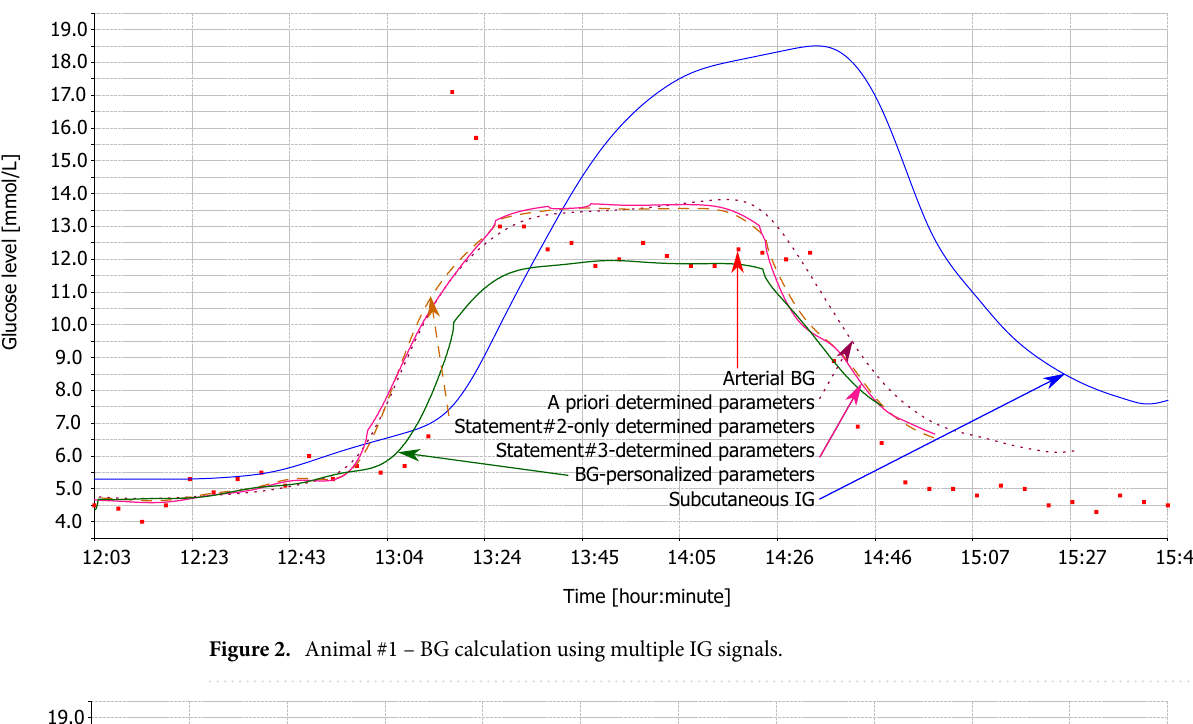
Figure 2. Animal #1 – BG calculation using multiple IG signals.